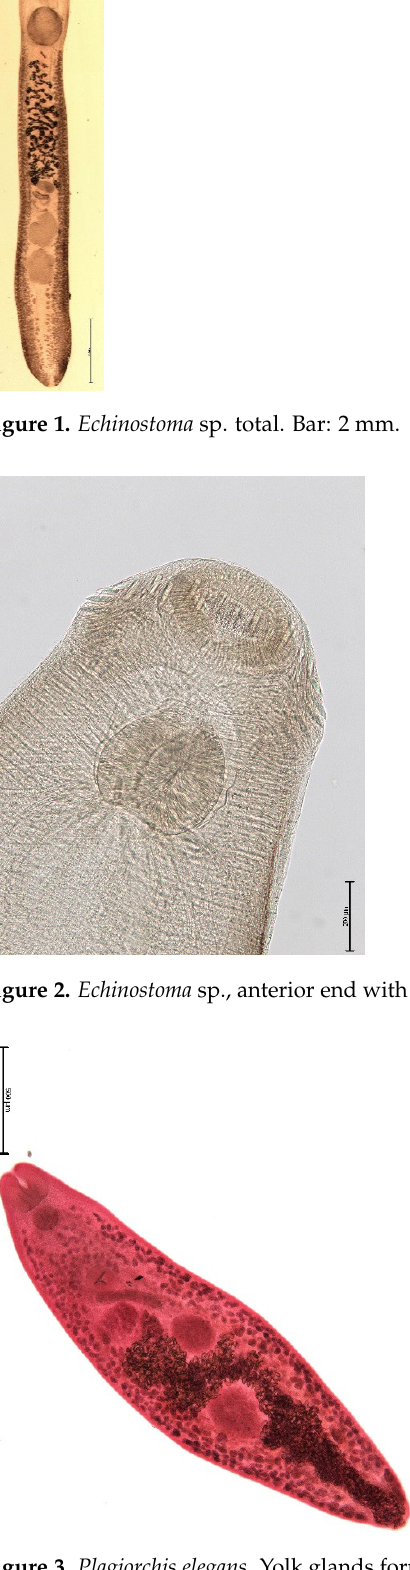
Figure 4. Plagiorchis arvicolae. Yolk glands fill most of the body. In unstained fresh specimens the trematode reminds an apple seed. Bar: 500 μm. Figure 5. Notocotylus noyeri. There is no ventral sucker but there are three rows of ventral glands. Testes and ovary are situated at the posterior end. Branches of the uterus reach laterally to yolk glands. Bar: 500 μm.